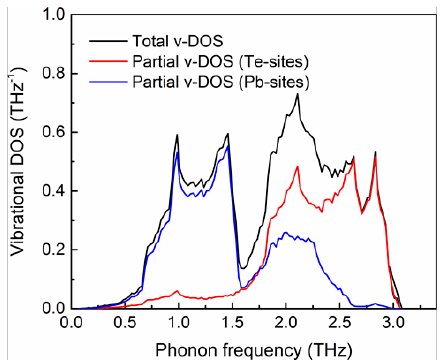
Figure 2. The vibrational density of states (v-DOS) of PbTe calculated from first principles. The total v-DOS appears in black, and the partial v-DOS of the Te- and Pb- sublattice sites appear in red and blue, respectively.